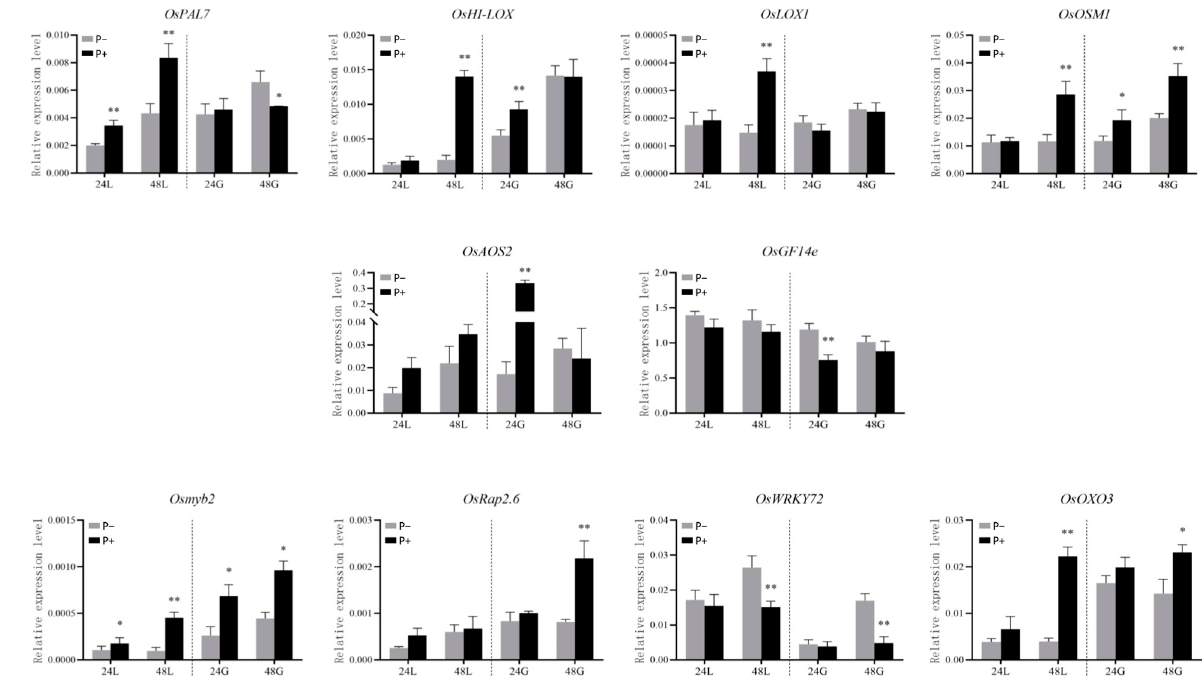
Figure 6. The relative expression levels of ten genes in the G and L varieties treated with PQQ and ddH 2 O treatments at 24 and 48 h after inoculation. Values shown are the means ± standard errors (SEs) of three biological replicates. Asterisks indicate significant differences among different treatments (* p < 0.05, ** p < 0.01).